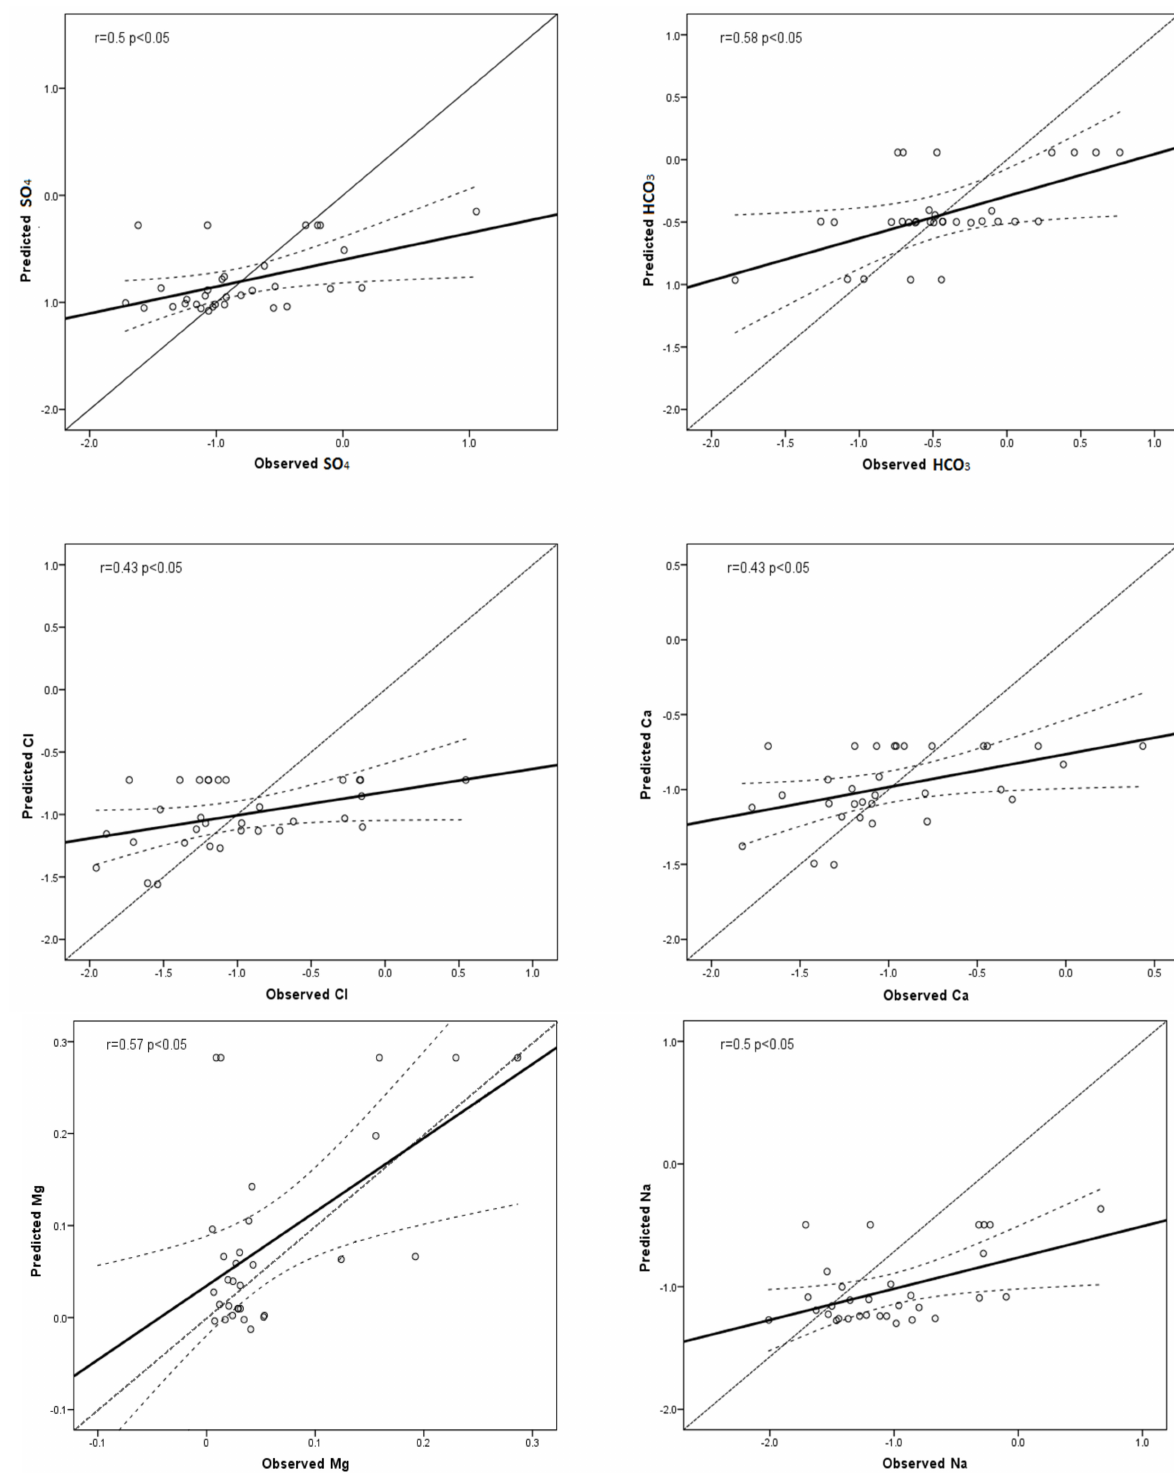
Figure 4. Observed vs. predicted values for water quality